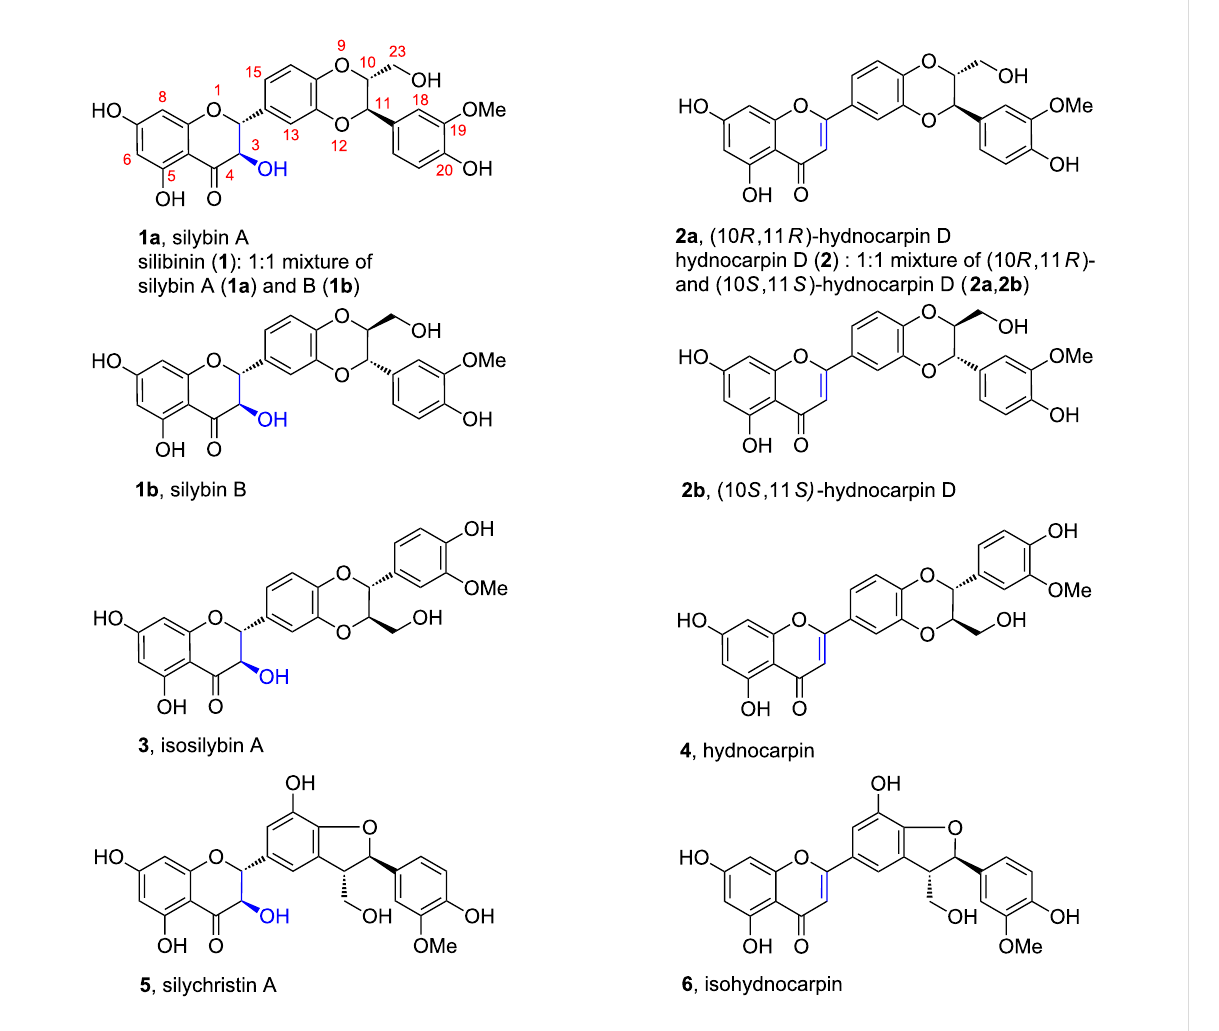
drosilibinin [1,5]. Natural and commercially available silibinin is the diastereomeric mixture (quasi equimolar) of silybin A ( 1a ) and silybin B ( 1b